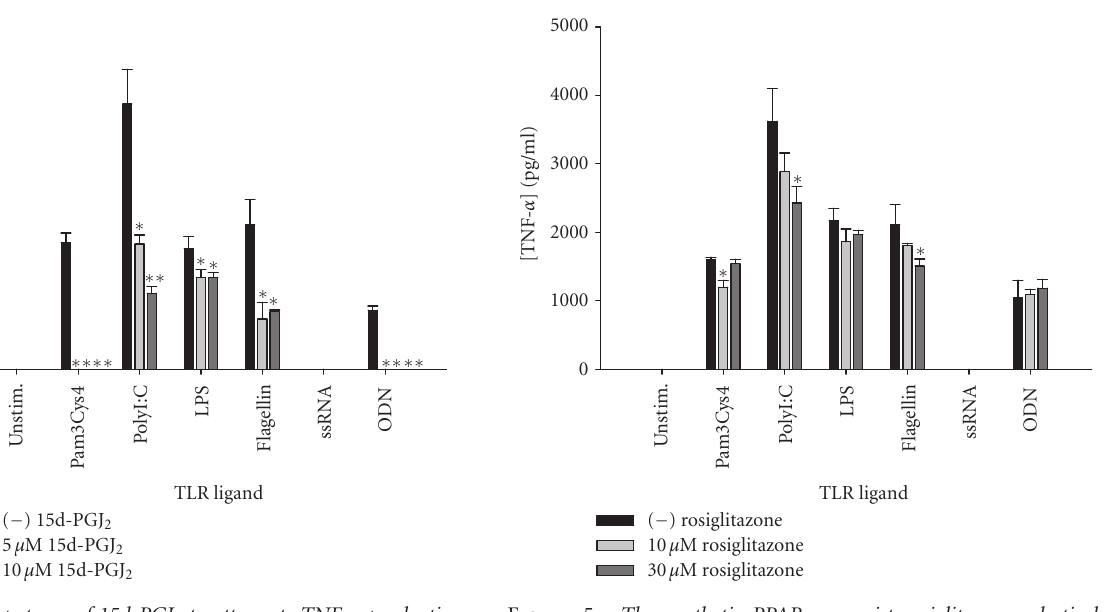
Figure 4: The potency of 15d-PGJ 2 to attenuate TNF- α production varies according to the TLR ligand examined. Primary microglia were plated at 2 × 10 5 cells/well in 96-well plates and incubated overnight. The following day, cells were pretreated for 1 hour with the indicated concentrations of 15d-PGJ 2 prior to the addition of TLR ligands. Cell-conditioned supernatants were collected at 24hours following TLR ligand exposure, whereupon TNF- α levels were determined by ELISA. Significant di ff erences between microglia treated with TLR ligands alone versus TLR ligands + 15d-PGJ 2 are noted with asterisks ( ∗ P < . 05; ∗∗ P < . 001). Results presented are representative of two independent experiments.